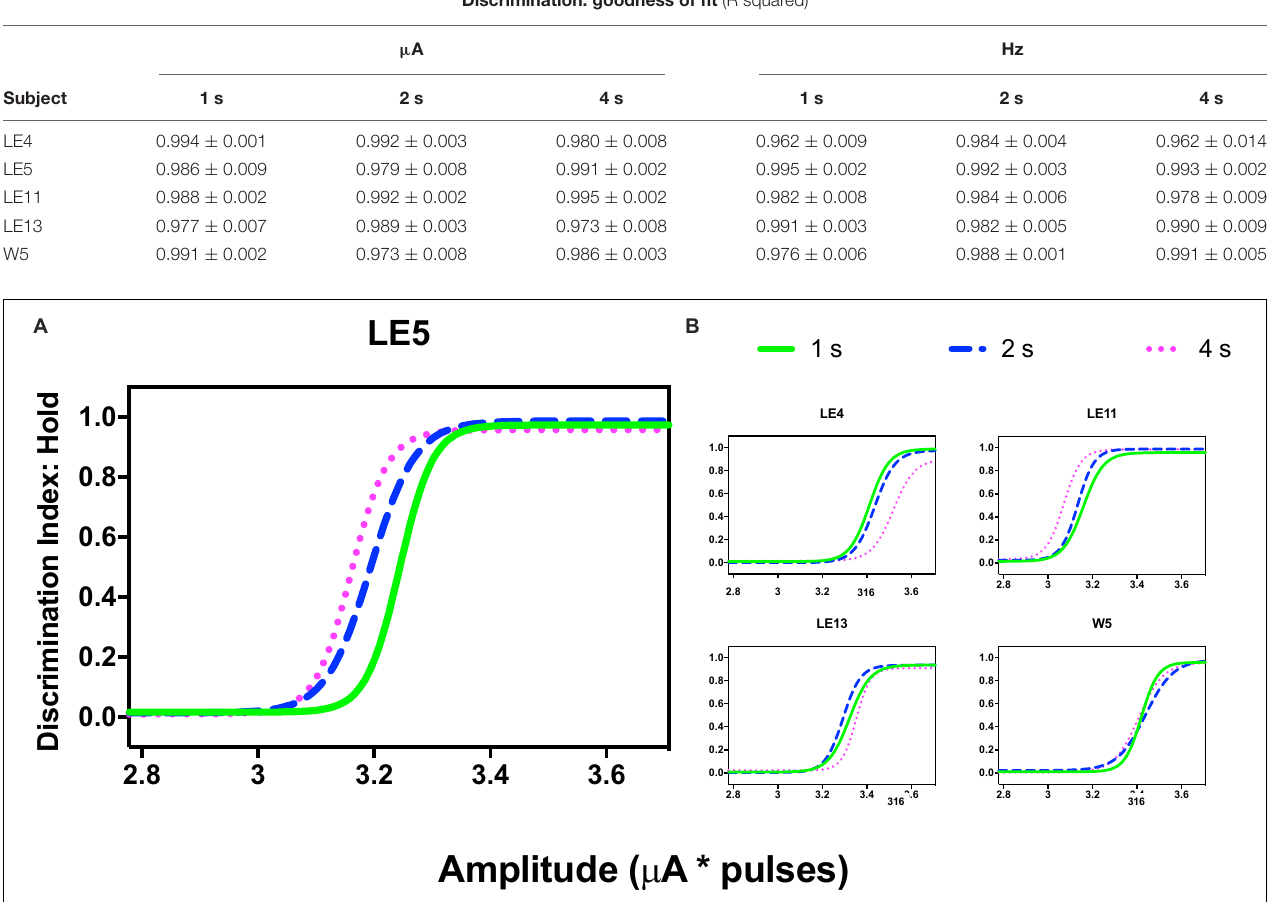
TABLE 2 | Mean goodness of fit of all series that correspond to each plot of generalization. Discrimination: goodness of fit (R squared)